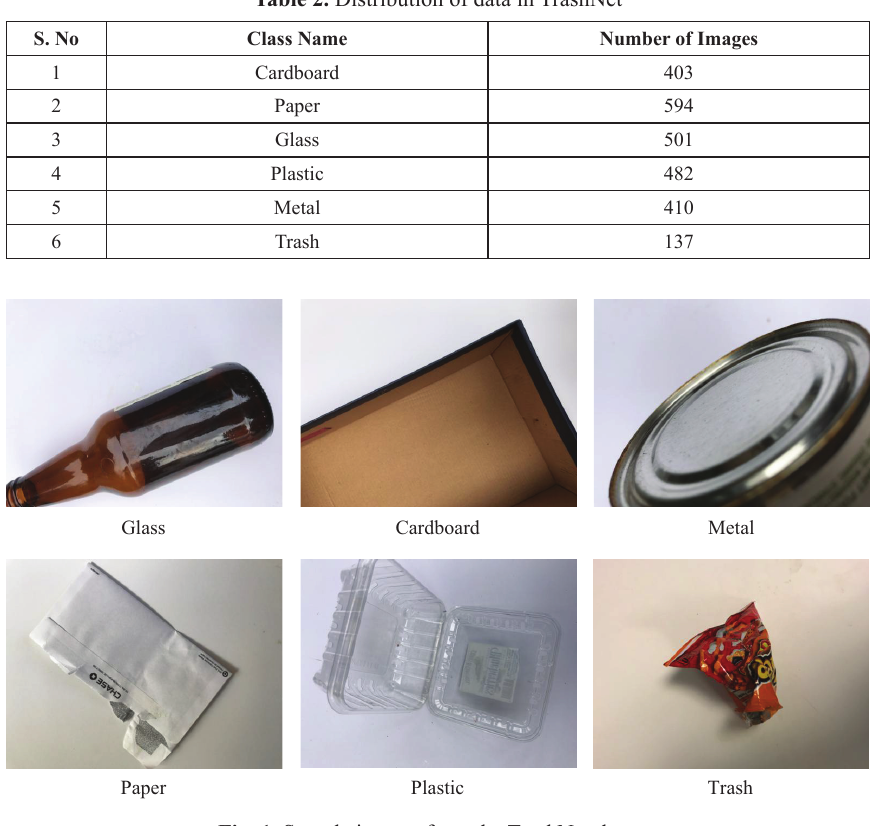
Fig. 1. Sample images from the TrashNet